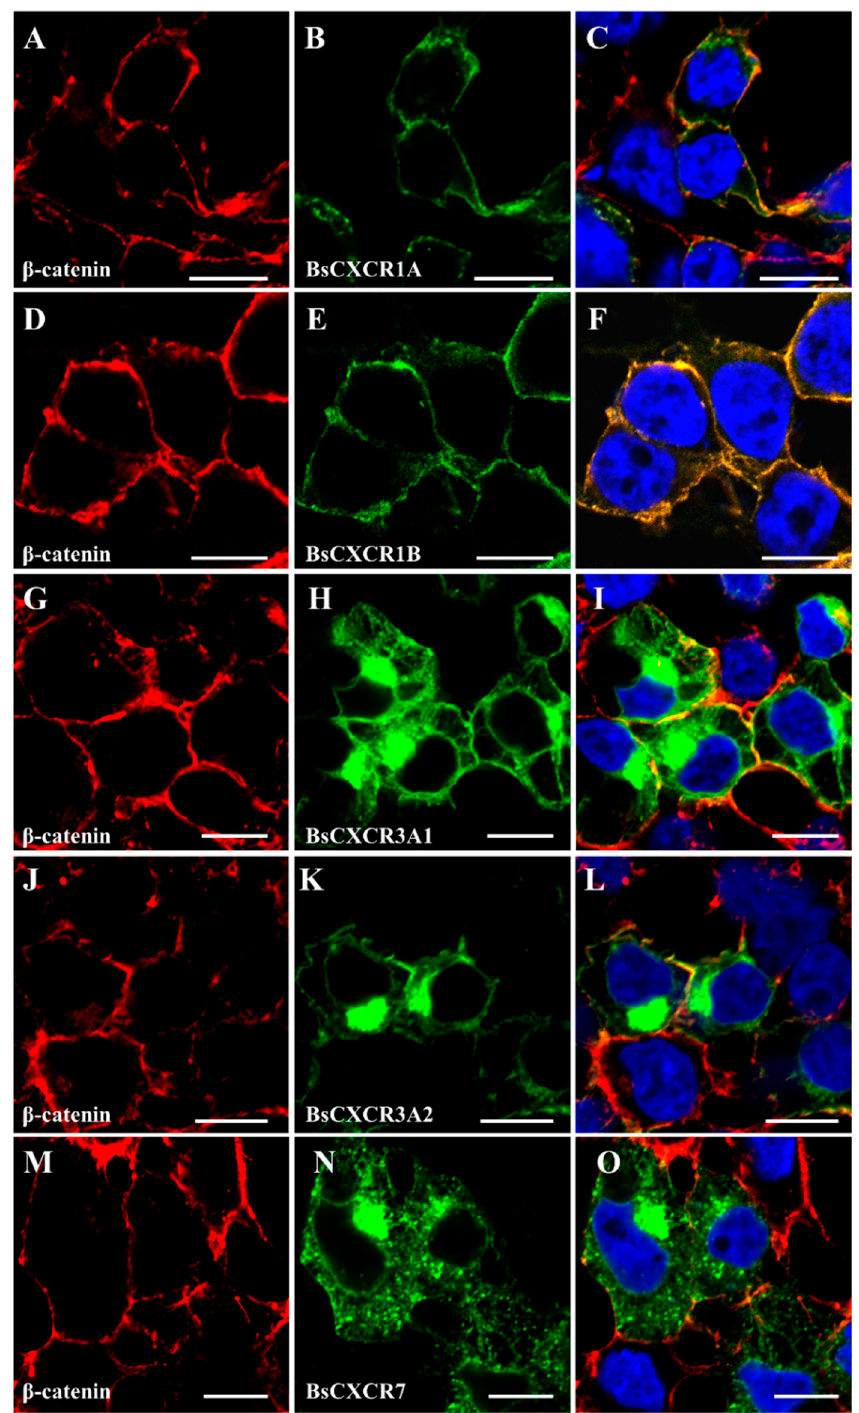
Figure 6. Subcellular localization of BsCXCR1a/1b, BsCXCR3a1/3a2 and BsCXCR7. The indicated recombinant plasmids were transfected in HEK293T cells. The cytomembrane was labeled by anti- β -catenin antibody using immunofluorescence. ( A , D , G , J , M ) β -catenin, ( B ) pEGFP-N3-BsCXCR1a , ( E ) pEGFP-N3-BsCXCR1b , ( H ) pEGFP-N3-BsCXCR3a1 , ( K ) pEGFP-N3-BsCXCR3a2 , ( N ) pEGFP-N3- BsCXCR7 , and ( C , F , I , L , O ) merged images. Scale bar, 10 μ m.